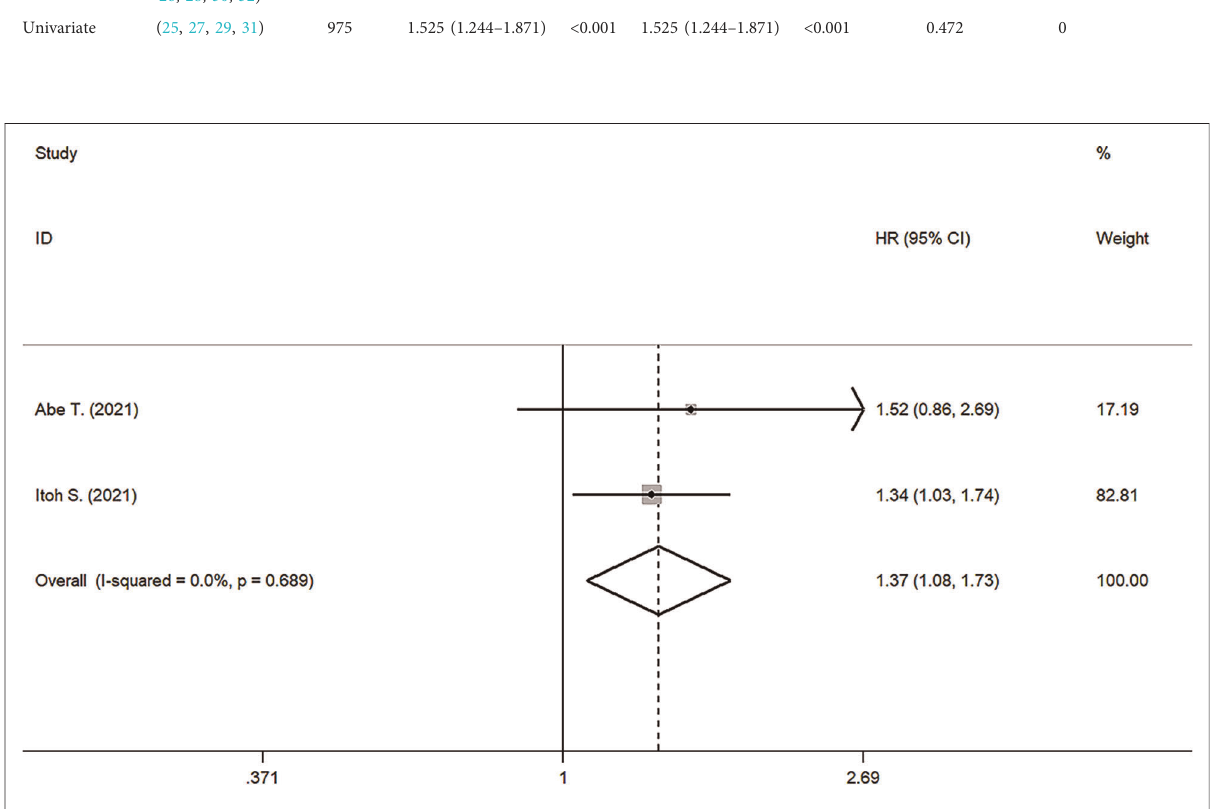
FIGURE 3 Forest plot of the association between PNI and RFS. (RFS, recurrence-free survival; HR, hazard ratio; CI, con fi dence